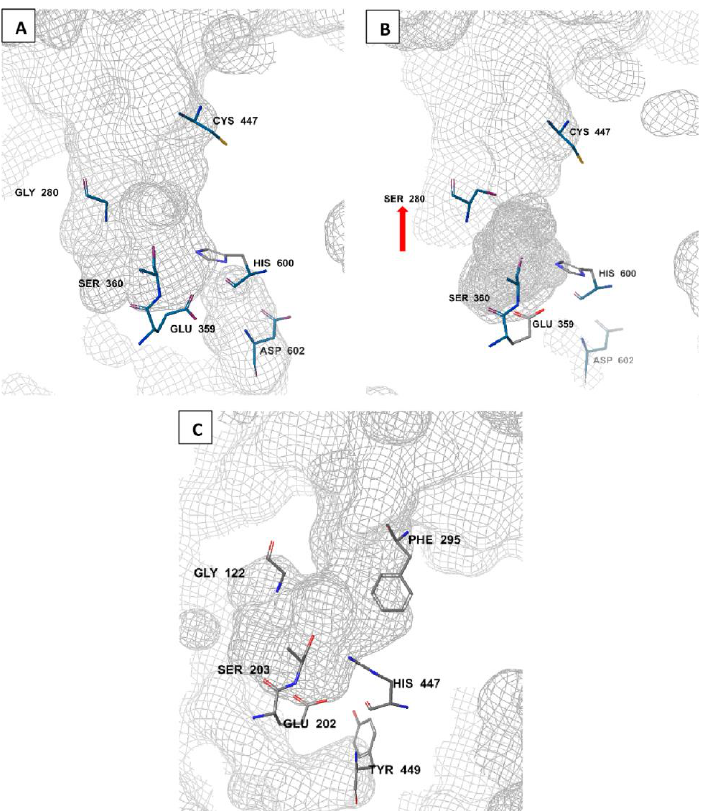
Figure 3. Molecular comparison of An. gambiae wild-type ( A ) and resistant ( B ) AChE catalytic sites (PDB IDs: 5YDI and 6ARY, respectively) to the human AChE (PDB ID: 7E3H) ( C ). generated by